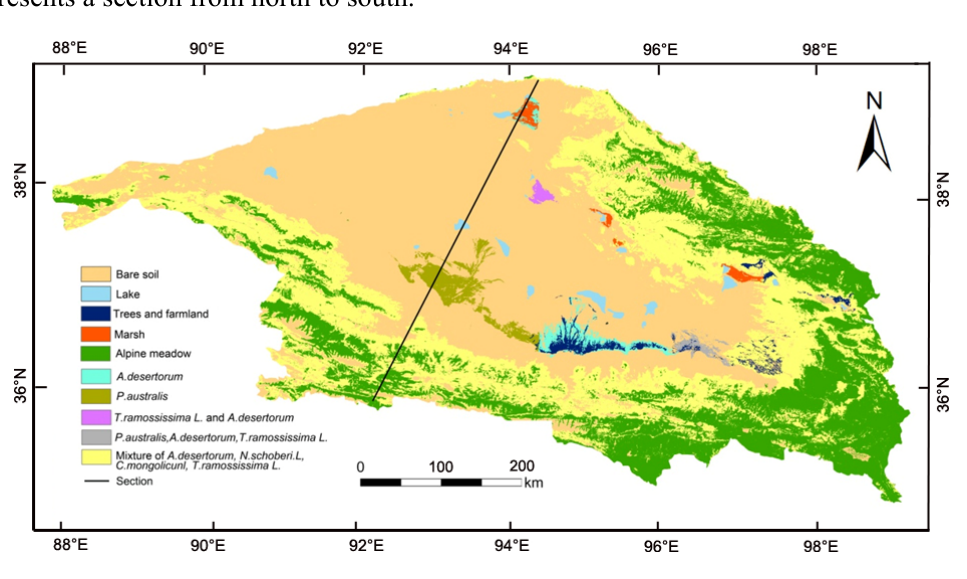
Figure 8. Variation of annual SEBS ET